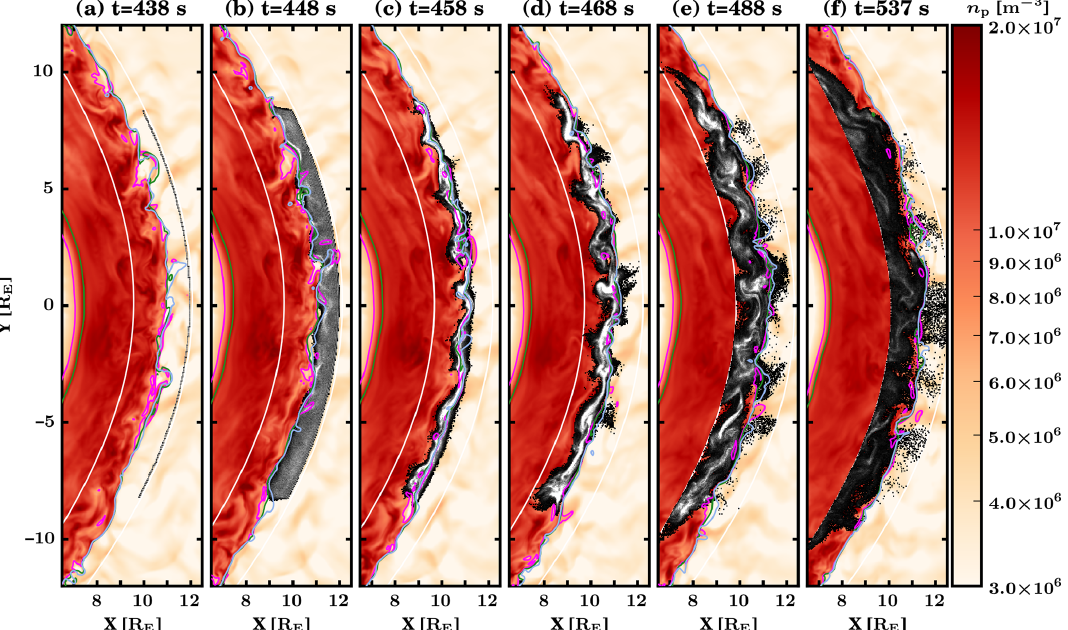
Figure 4. Test-particle propagation for simulation S1 and an Maxwellian 0.5 MK initialization at six different times. Vlasiator simulation proton number density is overlaid with the logarithmic density of test-particles in greyscale, with white indicating over 100 particles in a cell. Two black parabolas are the transmission boundary (left) and the injection boundary (right). Three contours indicate estimates of the local shock position: plasma compression (fuchsia, n p > 2 n p , sw ), solar wind core heating (green, T core > 4 T sw ), and the magnetosonic Mach number (pale blue, M ms <